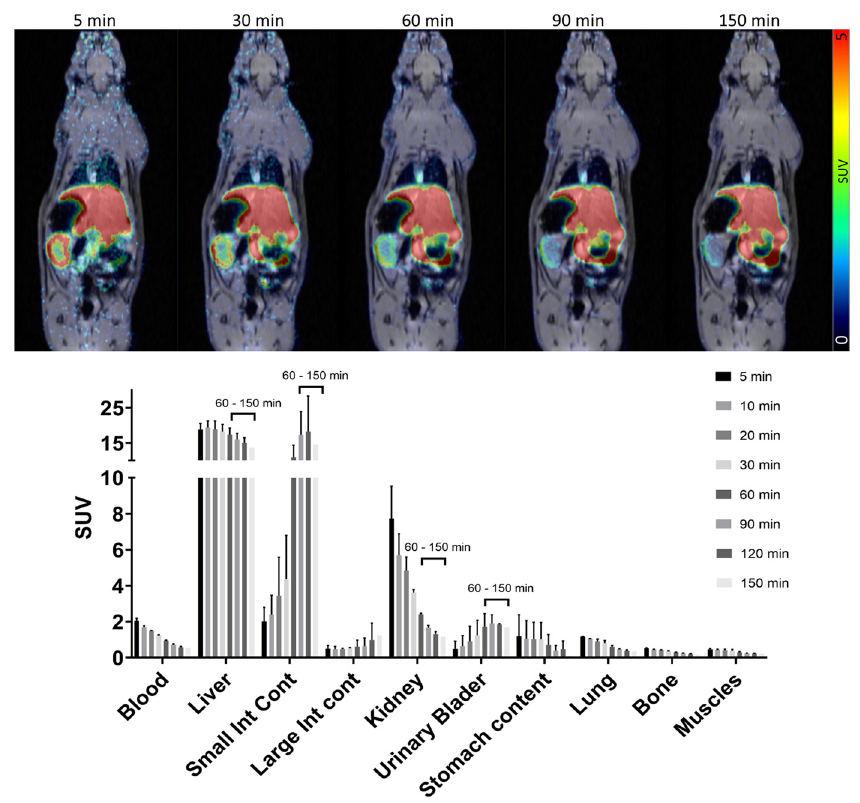
Figure 6. PET/MRI dynamic biodistribution of [ 18 F]MK-7246 in n = 2 rats over 150 min.